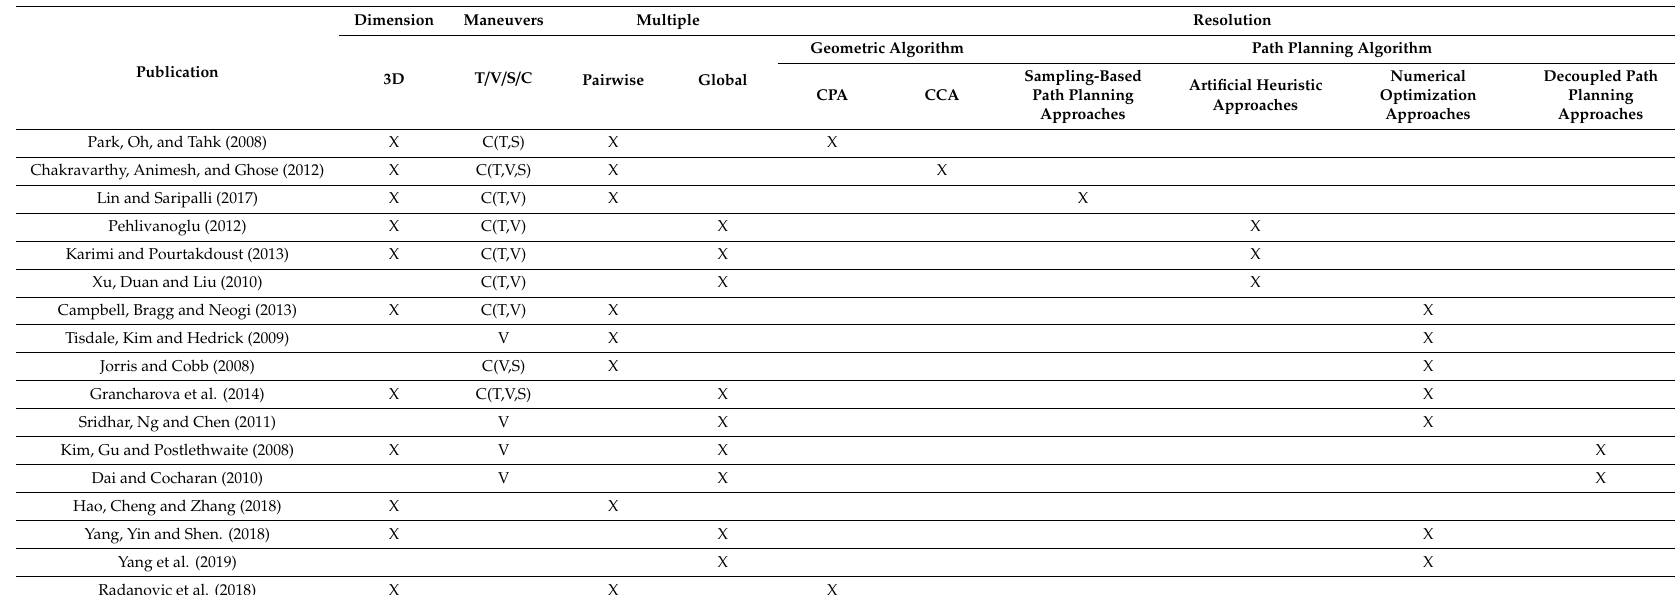
Table 1. Summary of publications addressing the CDR